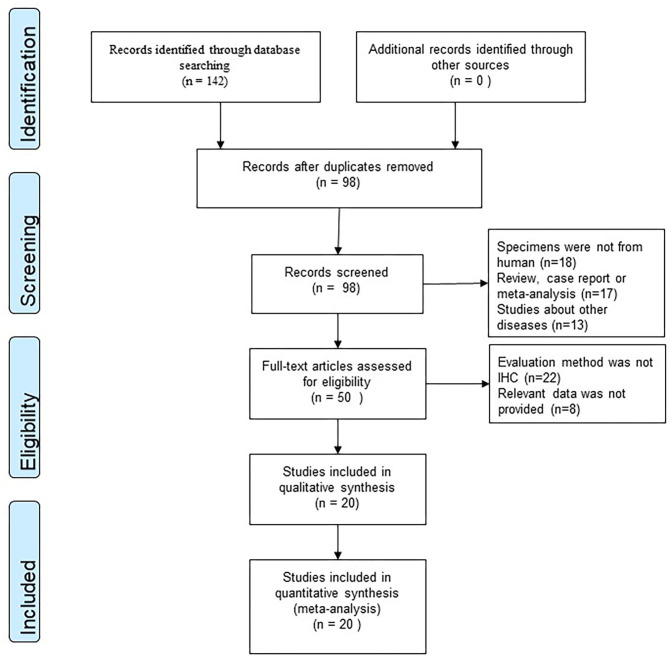
Flow diagram of the study selection procedure of the meta-analysis.